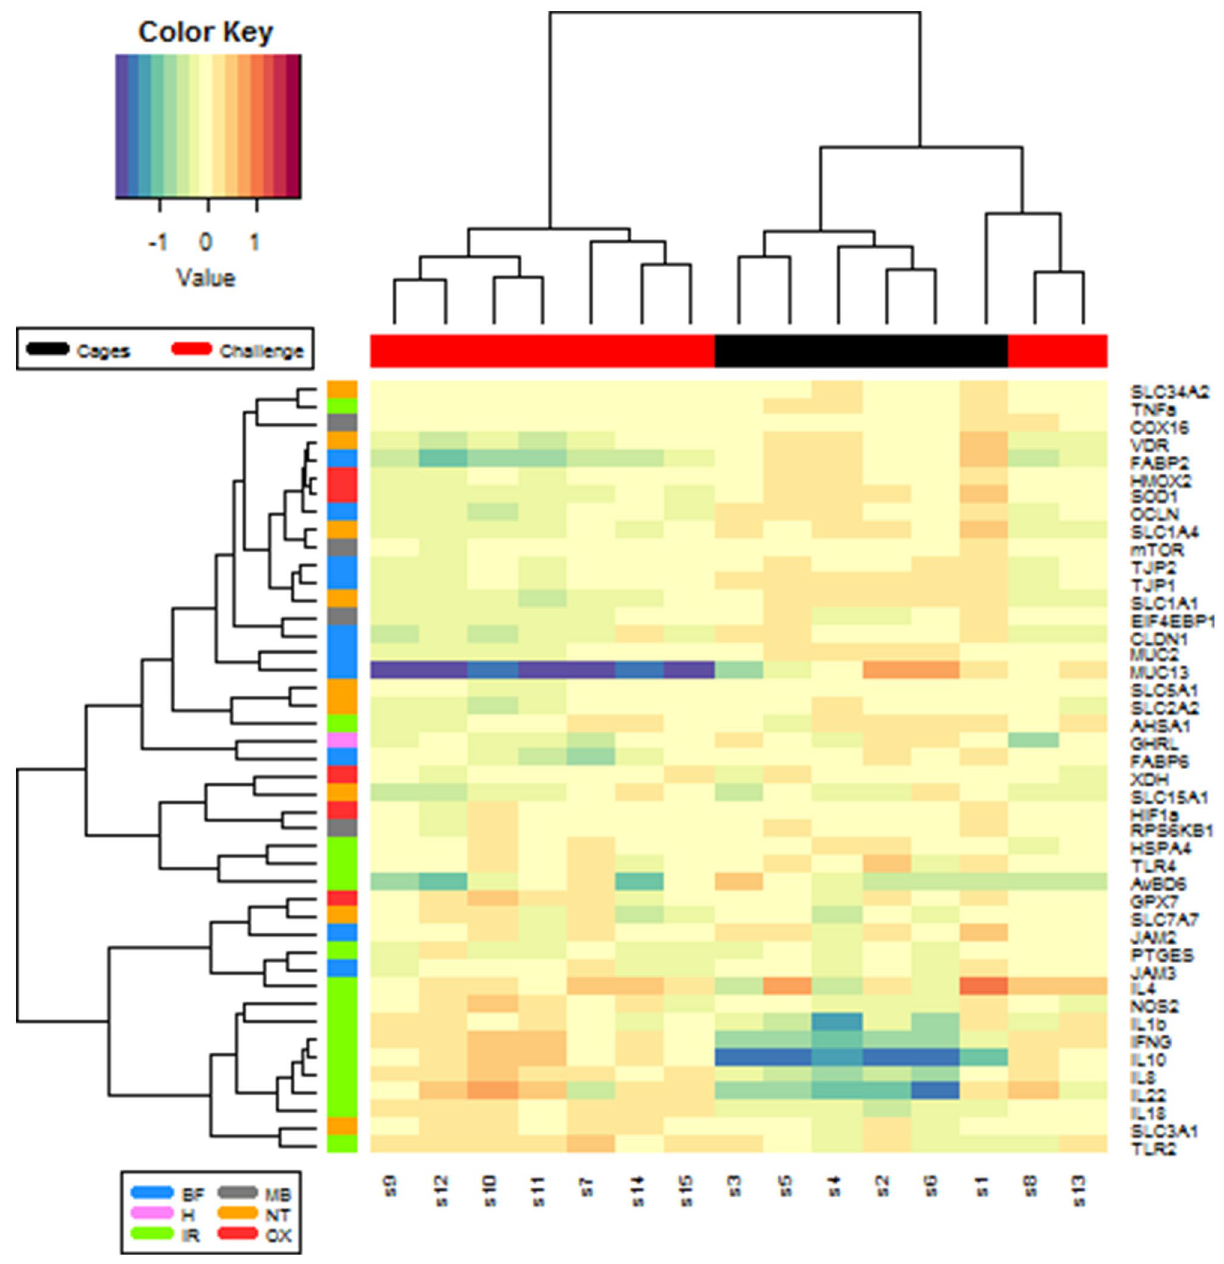
Figure 2. Heatmap of gene expression level of the 44 genes analysed in ileum. Genes were represented in the y-axis and samples in the x-axis. Experimental conditions (x-axis) were labelled in black colour for cages and red colour for challenging conditions. Groups of functions (y-axis) were labelled with different